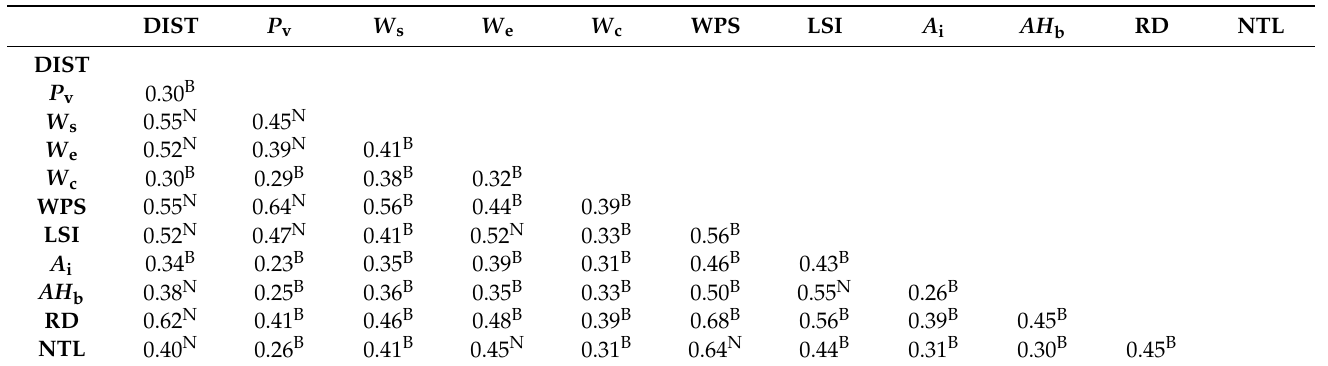
Table 5. Interaction analysis among potential influencing factors on WCI .